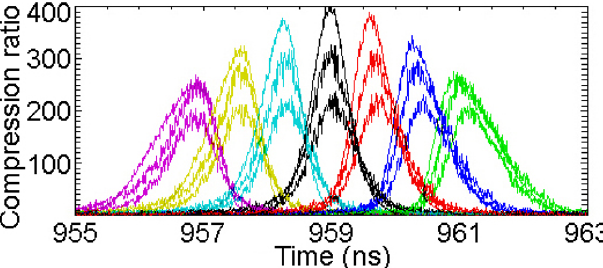
FIG. 10. (Color) Compression ratio I tween smooth (middle profiles) and sharp (bottom profiles) waveforms in the laboratory frame at multiple axial locations near the focal plane ( z (cid:4) (cid:8) 59 : 5 cm ), in steps of (cid:1) z (cid:4) 0 : 1 cm . The beams initialized with T k (cid:4) 0 : 2 eV are velocity tilted across the 3 cm long gap. The infinitely thin gap case results (including the spatial and temporal offsets) from Fig. 8 are provided for comparison (top profiles).